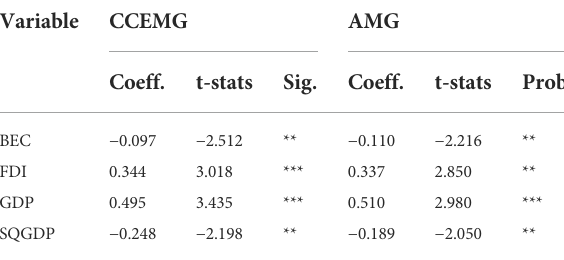
TABLE 5 Cross-sectional ARDL results.